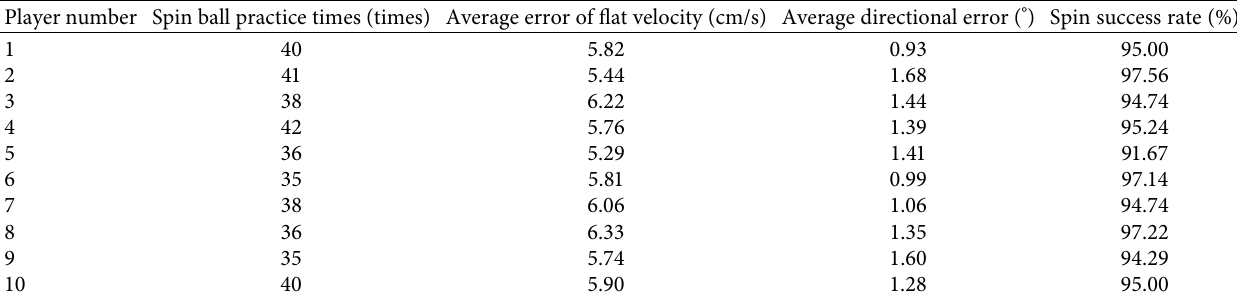
Table 7: Training results of athletes after using the method of multi-party process equation of